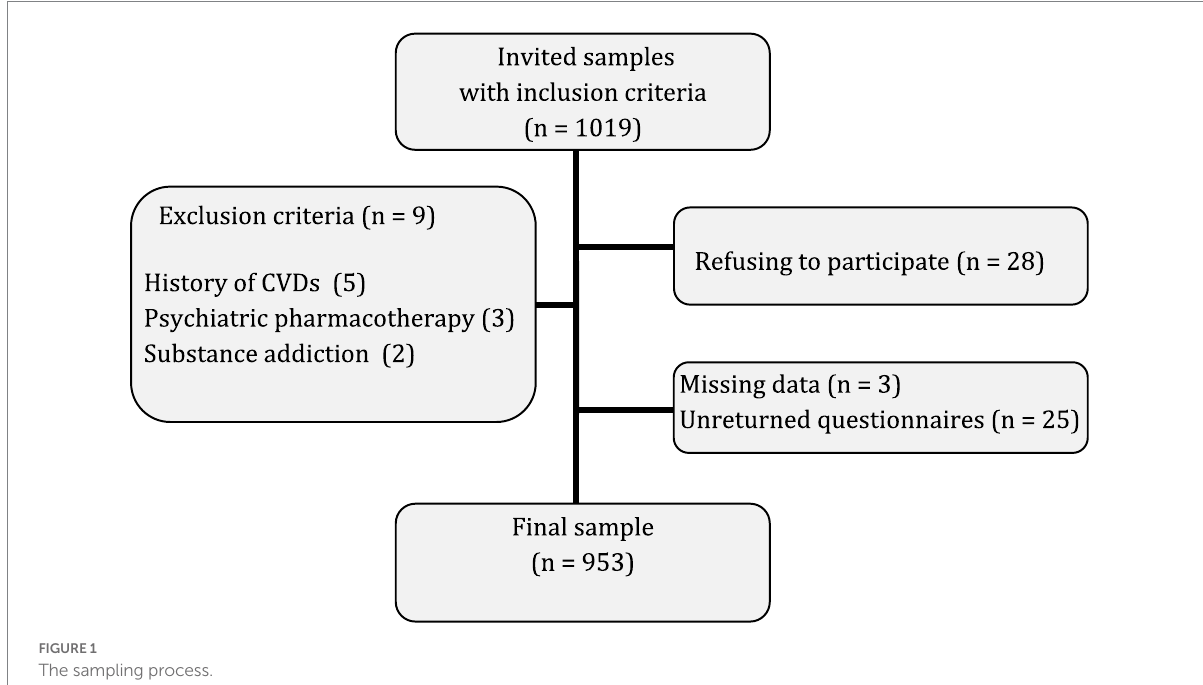
FIGURE 1 The sampling